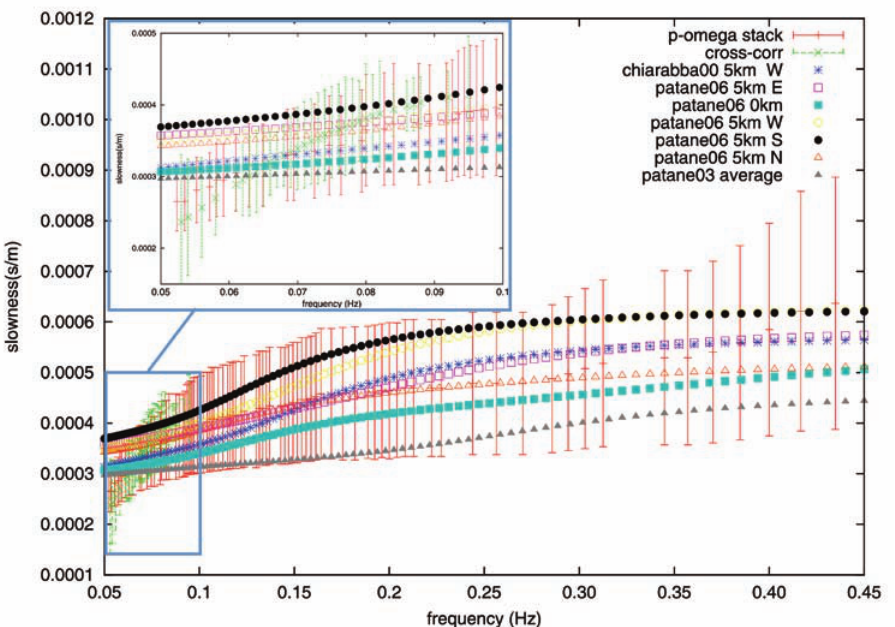
Figure 9. Comparisons between computed phase-velocity dispersion curves and those obtained solving the direct problem with the reference models from Chiarabba et al. [2000], Patanè et al. [2003] and Patanè et al.